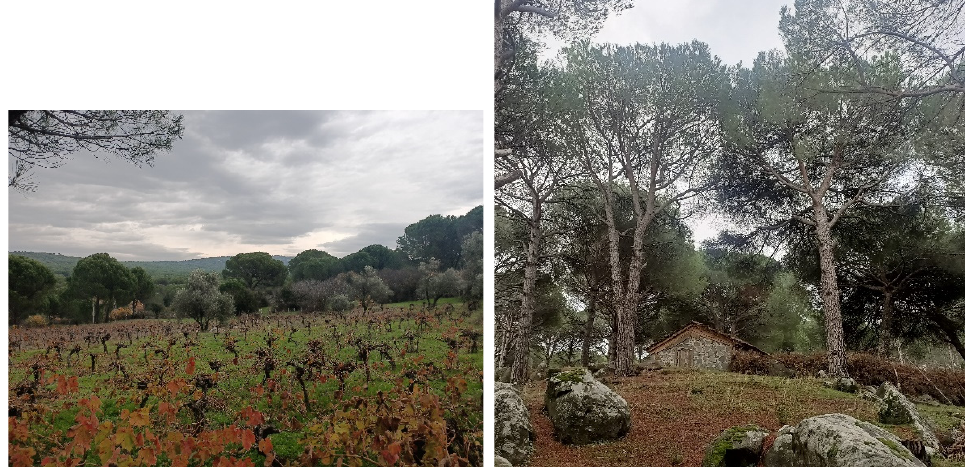
Figure 7. The vineyard cultivations in the Kozak Plateau. Source: authors’ pictures.